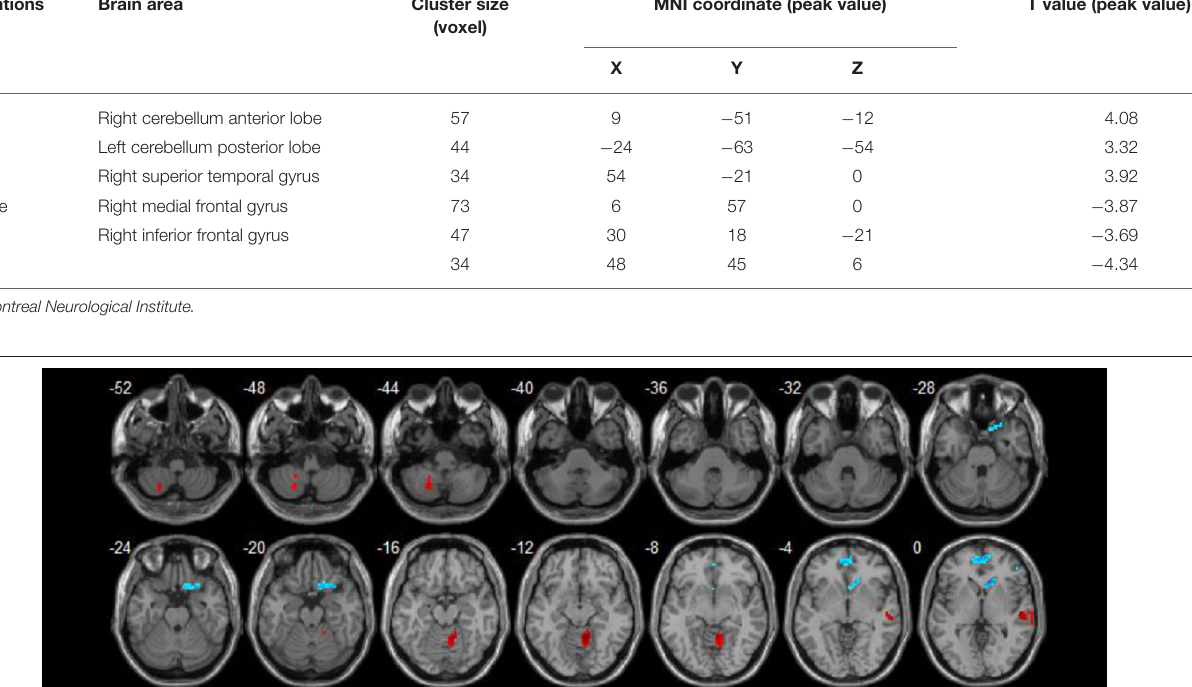
TABLE 3 | Correlations of ReHo values between brain areas and SLEDAI.